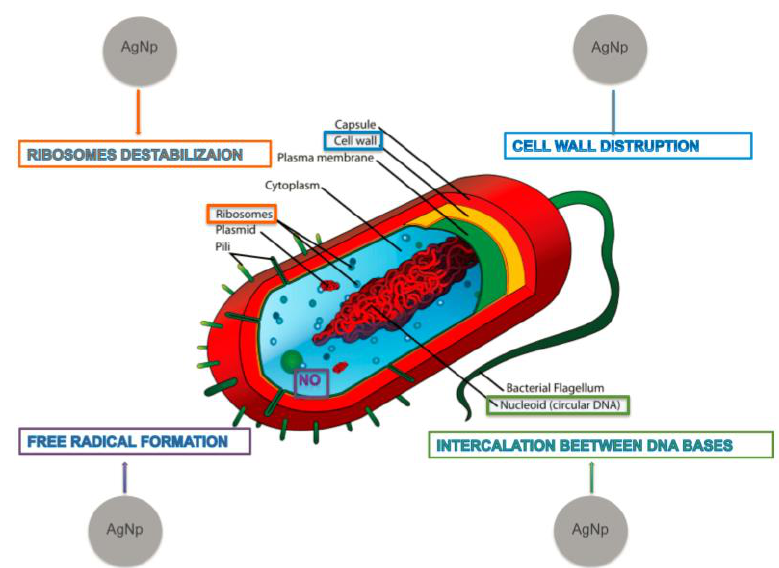
Figure 3. Silver nanoparticles' toxic action. Gram positive and Gram-negative bacteria react differently to Ag nanoparticles.